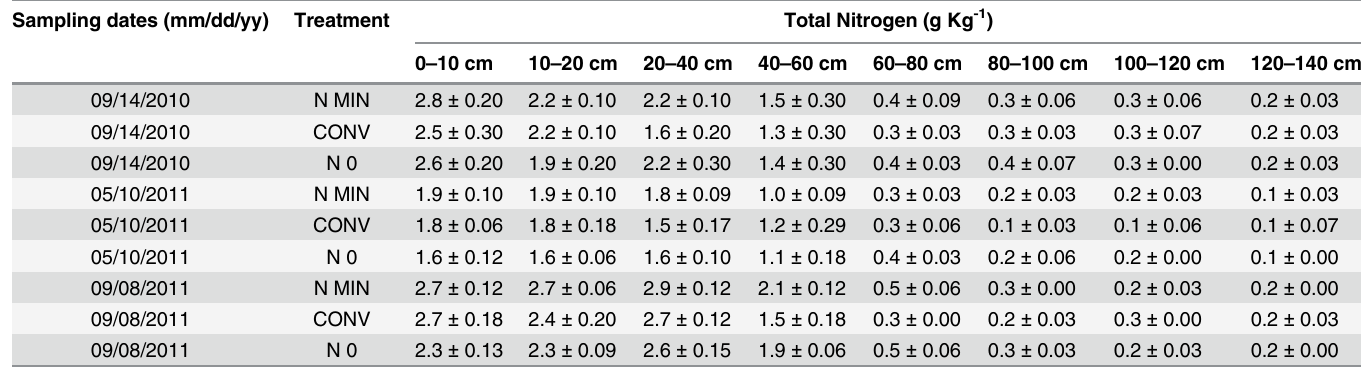
Table 5. Means and standard errors of total N content in soil profile layers related to three sampling dates during the maize-triticale-maize rotation for the N MIN, CONV and N0 treatments (n = 3). Sample dates correspond to the harvest of maize (09/14/2010), triticale (05/10/2011) and maize (09/08/ 2011). Dates are reported as